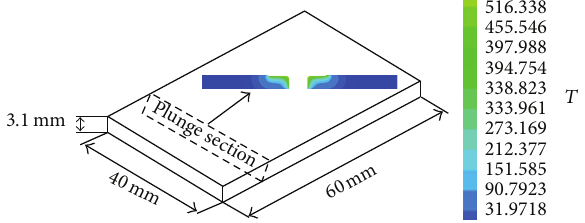
Figure 4: Contour of the temperature distribution in the plunging